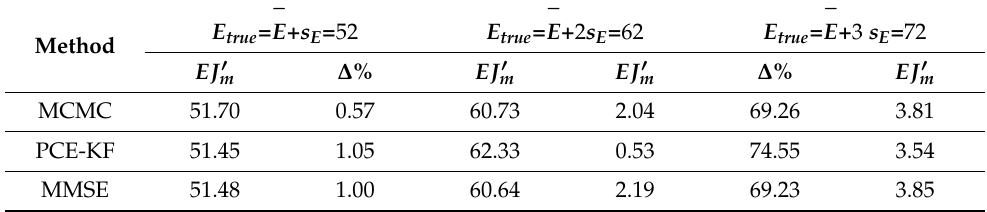
Table 11. Comparison of posterior mode E (cid:48) m and E true according to different updating procedures (after mapping) by measuring the displacement in two different